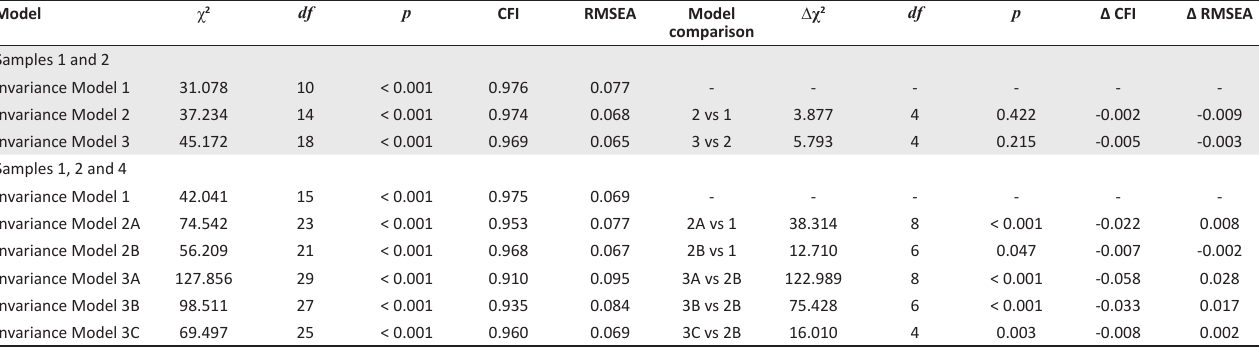
TABLE 6: Measurement invariance of the Harmony in Life Scale for Samples 1 and 2, and for Samples 1, 2 and 4. Model Model